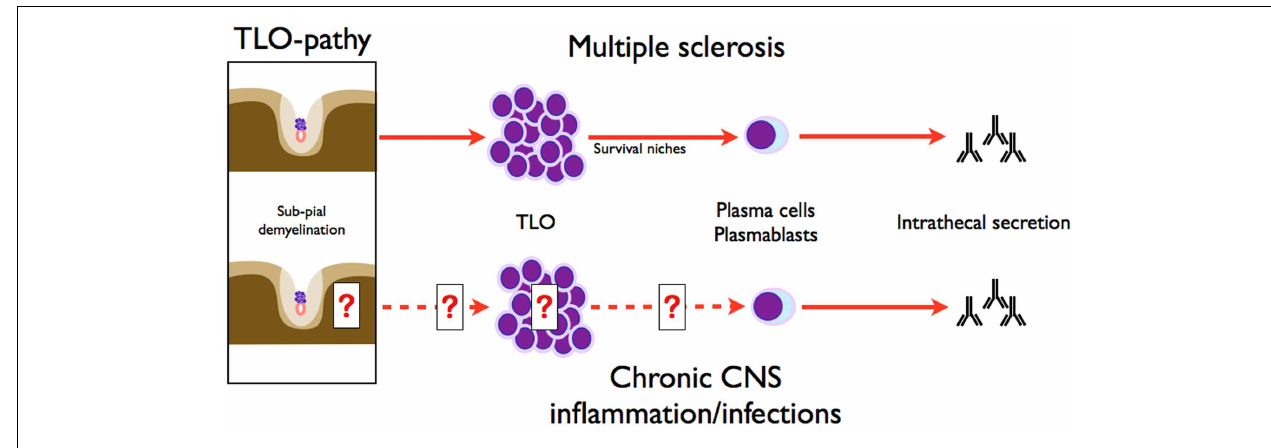
associated withTLO, as classically known in MS, but also in chronic CNS inflammation and infections.Therefore, sub-pial demyelination induced byTLO is not a hallmark of MS and defines the concept of